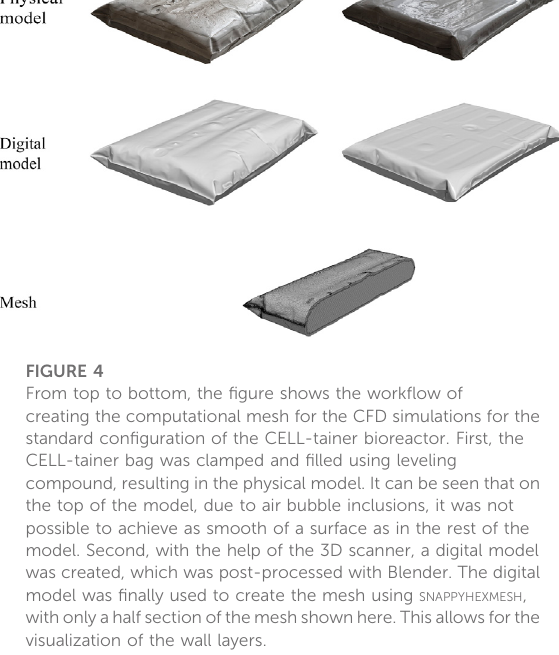
the meshes were chosen so that the mesh re fi nement ratio r was greater than 1.1 and was approximately 1.3 (Steffen et al., 1995; Roache, 1998; Meana-Fernández et al., 2019; Baker et al., 2020) (Eq. 10). The determination of the GCI was performed analogously to the calculations of Baker et al. (2020), Ramírez et al. (2020) and Pappalardo et al. (2021) (Eqs. 11, 12). Where ϕ i corresponds to the numerical solution with mesh i (in this case the averaged power input P / V ), and ^ p corresponds to the observed order of accuracy. The speci fi c power input averaged over one period (10 rpm, 11.5 L and 8.2 ° ) is substantially higher with the coarsest mesh ( ≈ 8.1 W m − 3 ) than with the relative error ε mn . This demonstrates the strong in fl uence of the mesh on the speci fi c power input. Since the fi rst case resulted in a negative observed order of accuracy, and since the solutions thus diverge monotonically, the GCI could not be applied (Baker et al., 2020). In the second case the GCI could be applied and the quotient GCI i + 2 ,i + 1 is close to 1, which is an r p GCI i + 1 ,i indication that the solutions are in the asymptotic range of convergence. For this reason, combined with economical reasons (simulation times are shown in Table 1), mesh 2 was used for the subsequent simulations. Analogously, a mesh for geometry with expansion channels was chosen, which possesses 1.577 · 10 6 cells.